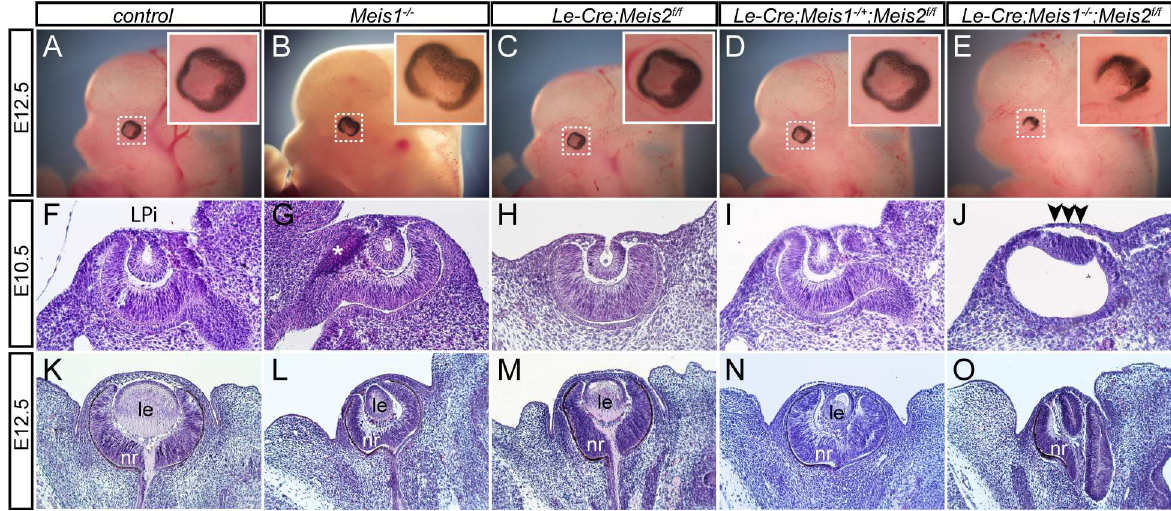
Fig 1. The phenotypic consequences of Meis1 and Meis2 deficiency. ( A-E ) At E12.5, externaleyes of whole-mount Meis1 -/- , Le- Cre;Meis2 f/f , Le-Cre;Meis1 +/- ;Meis2 f/f mutant appearcomparable to control eye, whereasthe eye of Le-Cre;Meis1 -/- ;Meis2 f/f double mutant has abnormal shape. The insets show high magnification of eye region(boxed). ( F-O ) Hematoxylin-eosinstainedparrafin sections show histologyof control or mutant E10.5 and E12.5 eyes. ( F-H , K-M ) Formation of lens placodeis followedby invagination of surface ectodem, formation of lens pit (LPi) and subsequent formation of lens in control, Meis1 -/- and Le-Cre;Meis2 f/f embryos. ( I , N ) One active Meis1 allelein Le-Cre;Meis1 -/+ ; Meis2 f/f embryos is sufficient for lens placodeand lens formation. ( J , O ) In Le-Cre;Meis1 -/- ;Meis2 f/f embryos, deficientfor both Meis1 and Meis2, lens development is arrested in pre-placodal stage (arrowheads). * Artefact, le-lens, nr-